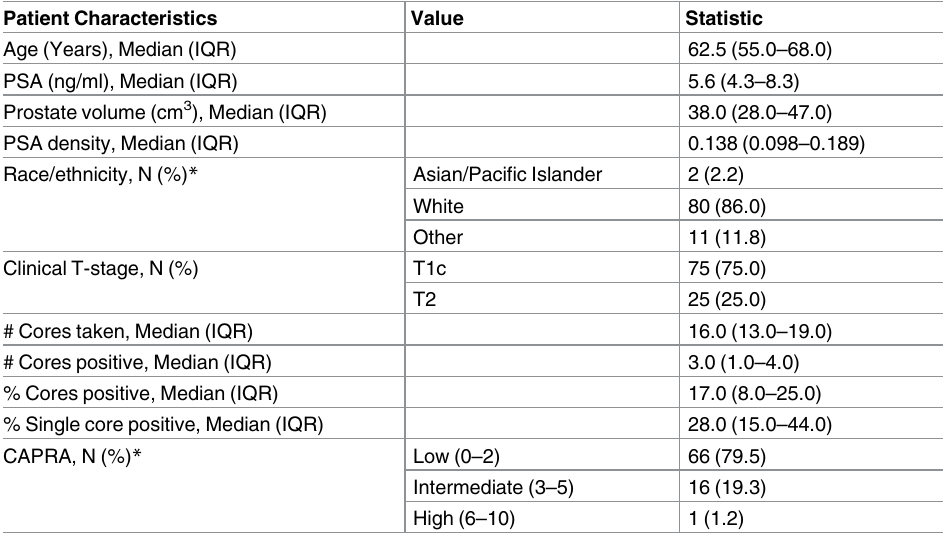
Table 2. Baseline characteristics of 100 patients receiving multi-parametric prostate MRI and GPS testing. Patient